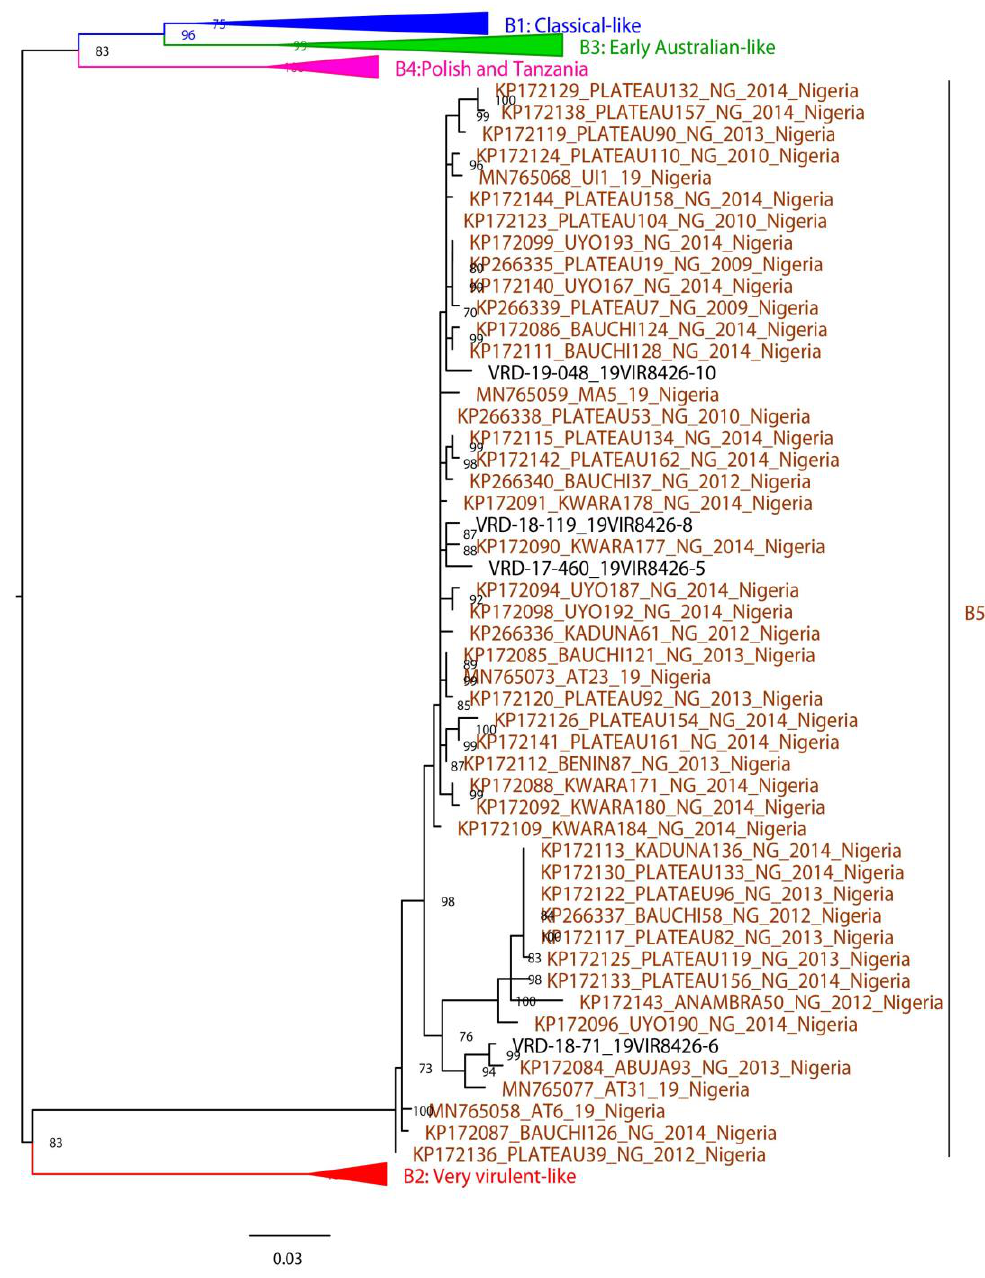
Figure 3. Phylogenetic tree of nucleotide sequences of partial segment B of IBDV based on VP1 N-terminal domain and finger subdomain of central polymerase. Maximum likelihood method with the best-fit model (GTR+F+R4) automatically identified by IQ-TREE v.1.6.12. All genogroups except B5 (brown color) have been collapsed. The ultra-fast bootstrap values higher than 70% are indicated near the